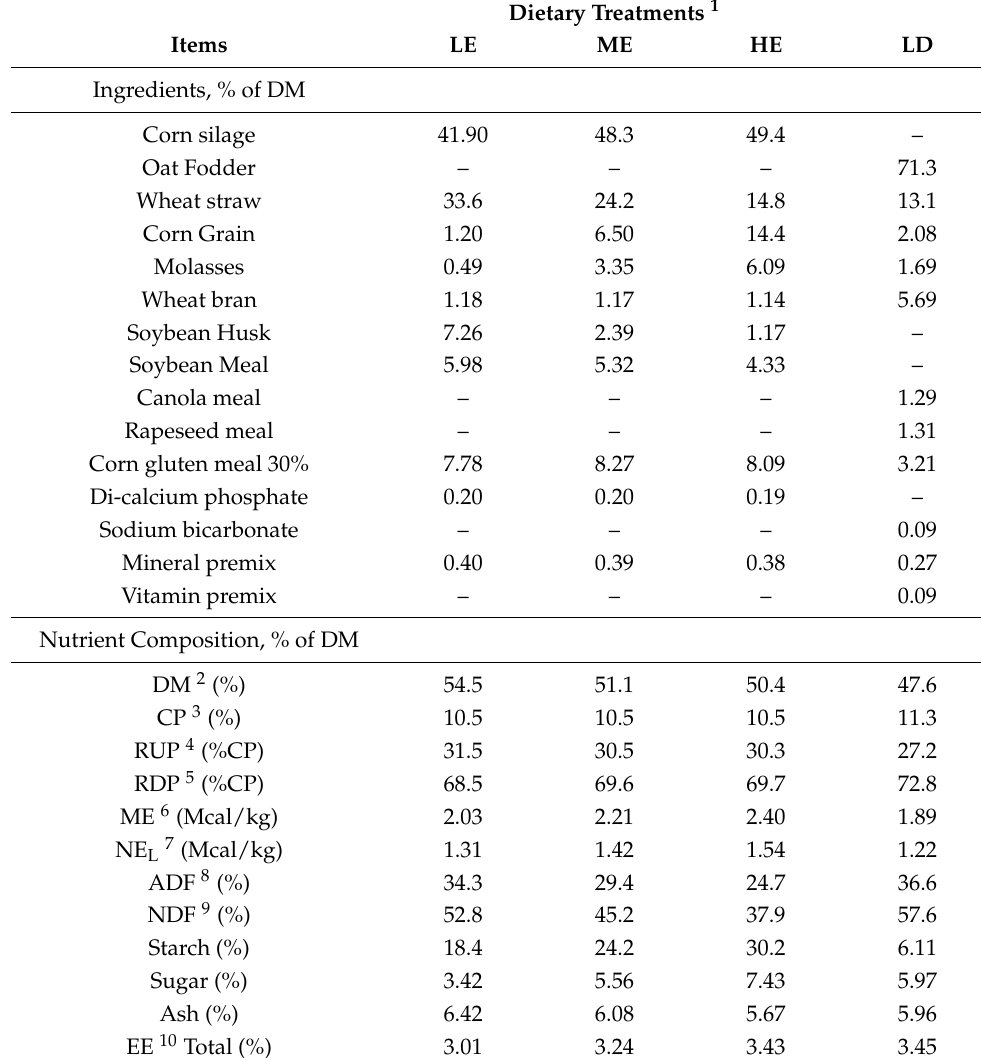
Dietary Treatments